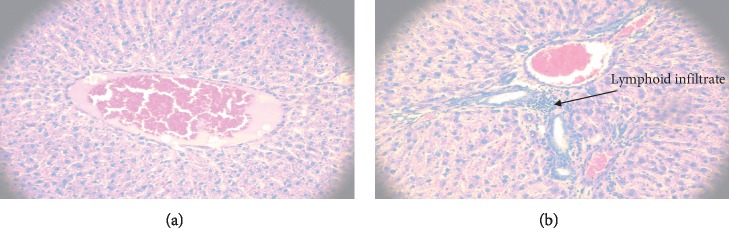
Comparison of histological sections of liver tissue of a healthy male Wistar rat (a) and a rat treated with C. ternifolia at 8.5 mg/kg (b) both with a haematoxylin and eosin stain. A lymphoid infiltrate is observed in the rat that received treatment.